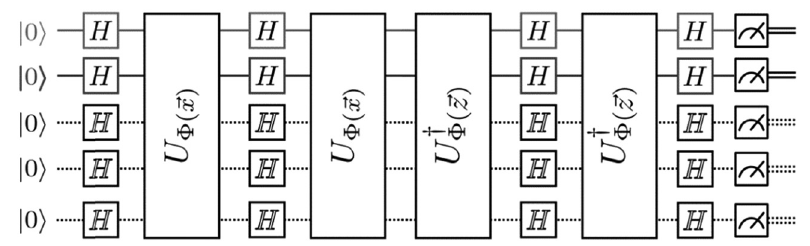
Figure 4: Estimating the x x Φ Φ i j 2 ∣〈 ( )∣ ( )〉∣∣ overlap for a circuit of depth S = 2, where V